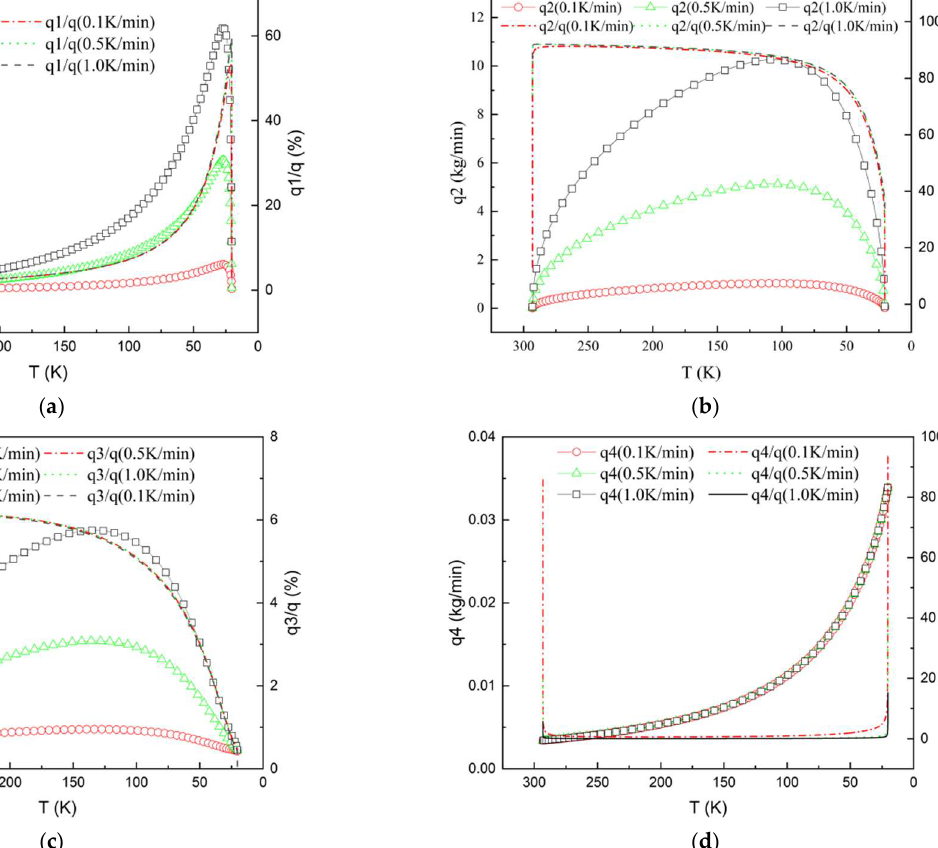
Figure 6. Hydrogen mass and flow of heat loads at different cooling rates: ( a ) inner gas q 1 ; ( b ) inner wall and accessories q 2 ; ( c ) thermal insulation material q 3 ; ( d ) heat leakage offset q 4 .